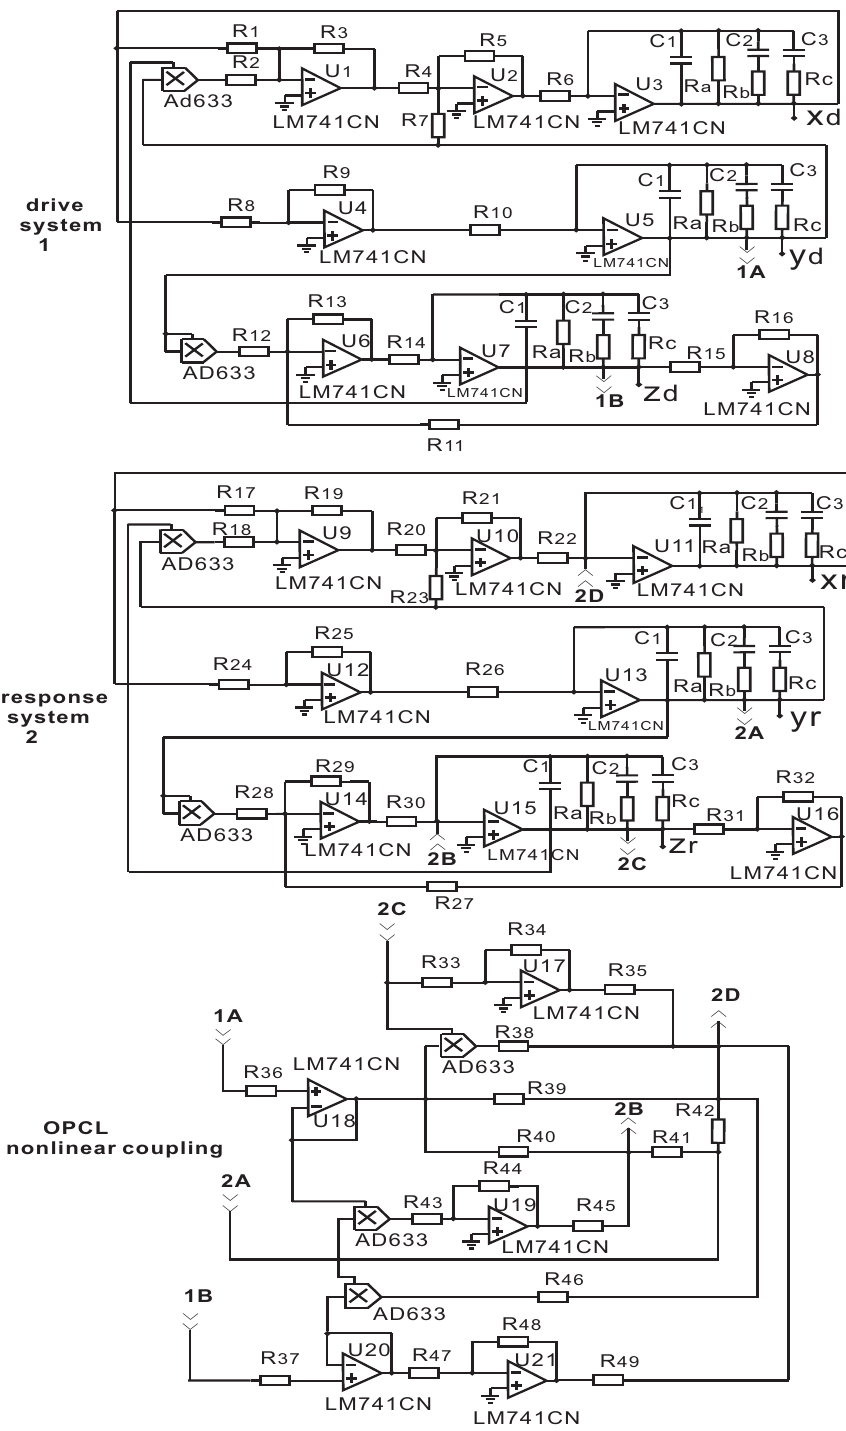
Figure 5. Coupled 2.85-order Rucklidge circuit. System 1 drives the response system 2 by OPCL nonlinear coupling. Please note that 1% tolerance of component values are